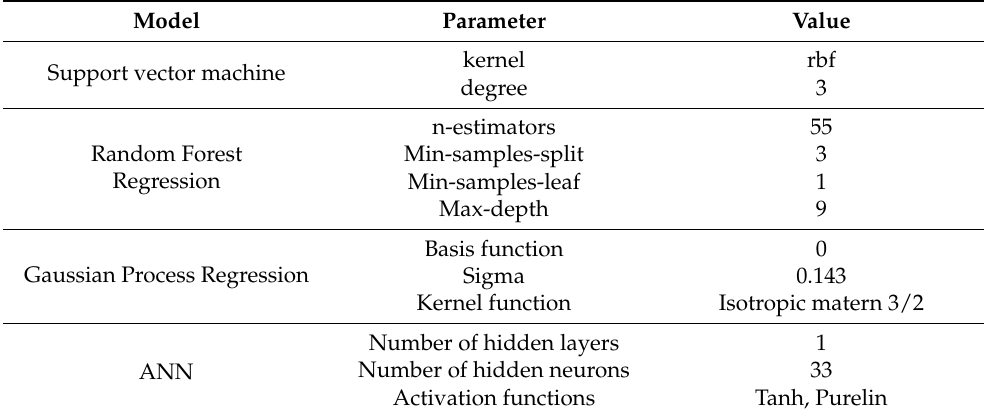
Table 2. Hyper-parameter tuning values of developed machine learning models.